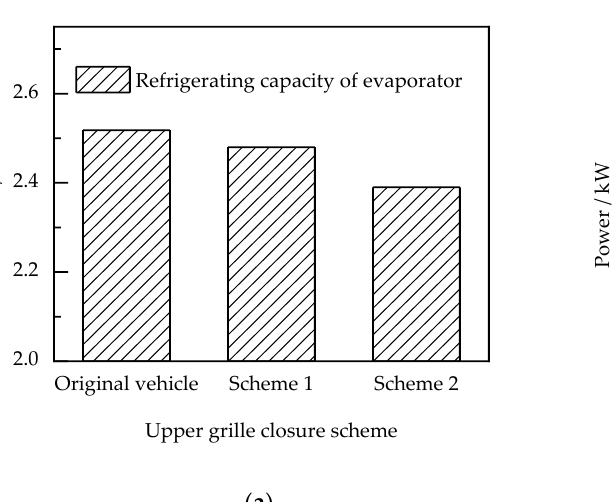
Figure 18. The temperature fields of z = 0.44 m section under different upper grille closure schemes: ( a ) original vehicle; ( b ) scheme 1; ( c ) scheme 2.